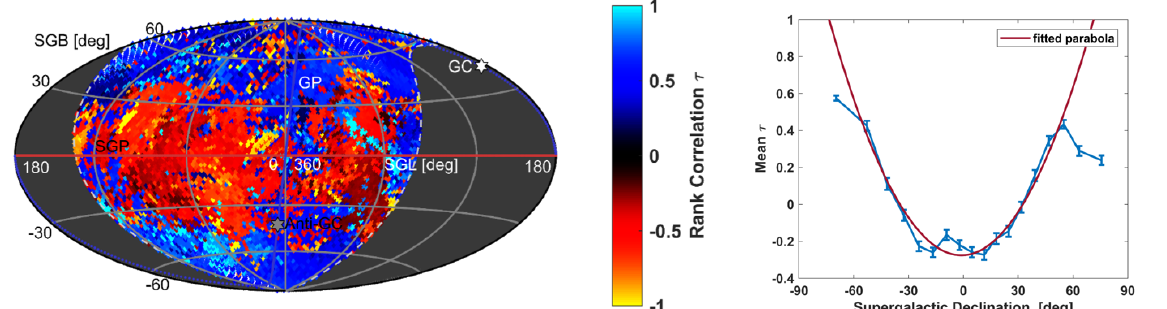
Figure 7. (Left) The sky map of the correlation strength (cid:28) in the supergalactic coordinate taken from [19]. The solid gray curve and red horizontal line indicate galactic plane (GP) and supergalactic plane (SGP), respectively. White and grey stars indicate the Galactic center (GC) and anti-galactic center (Anti-GC). (Right) The mean (cid:28) inside equal solid angle bins for the data as a function of the supergalactic latitude. The solid red curve shows the best-fit curve to the data by the parabola function ( ax 2 + bx + c ).